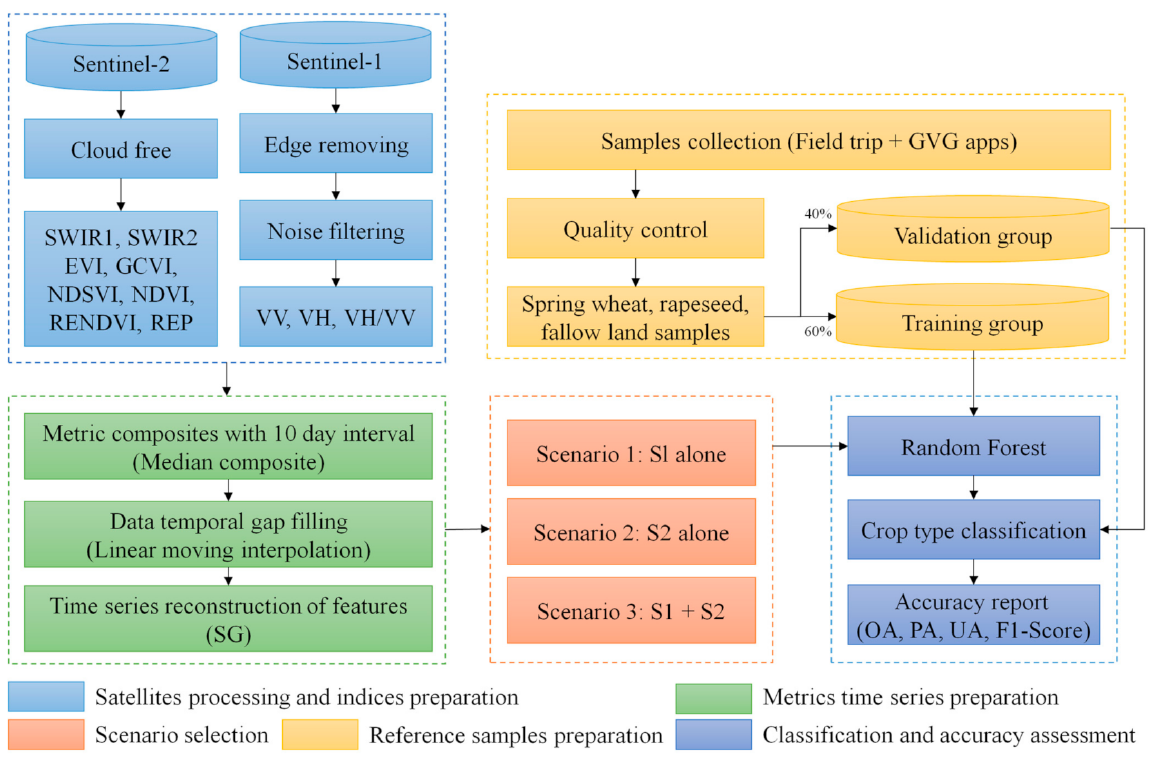
Figure 5. Flowchart of crop